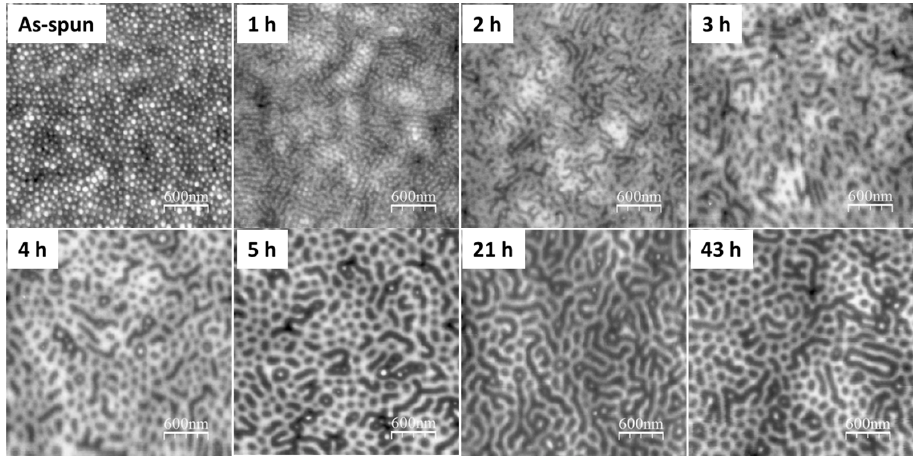
Figure 2. AFM surface height profiles of 60 nm PS- b -P2VP thin films spin-coated at 3000 rpm from 1.5 wt % solution in toluene with further annealing under toluene vapor atmosphere at 50 °C with different annealing times.